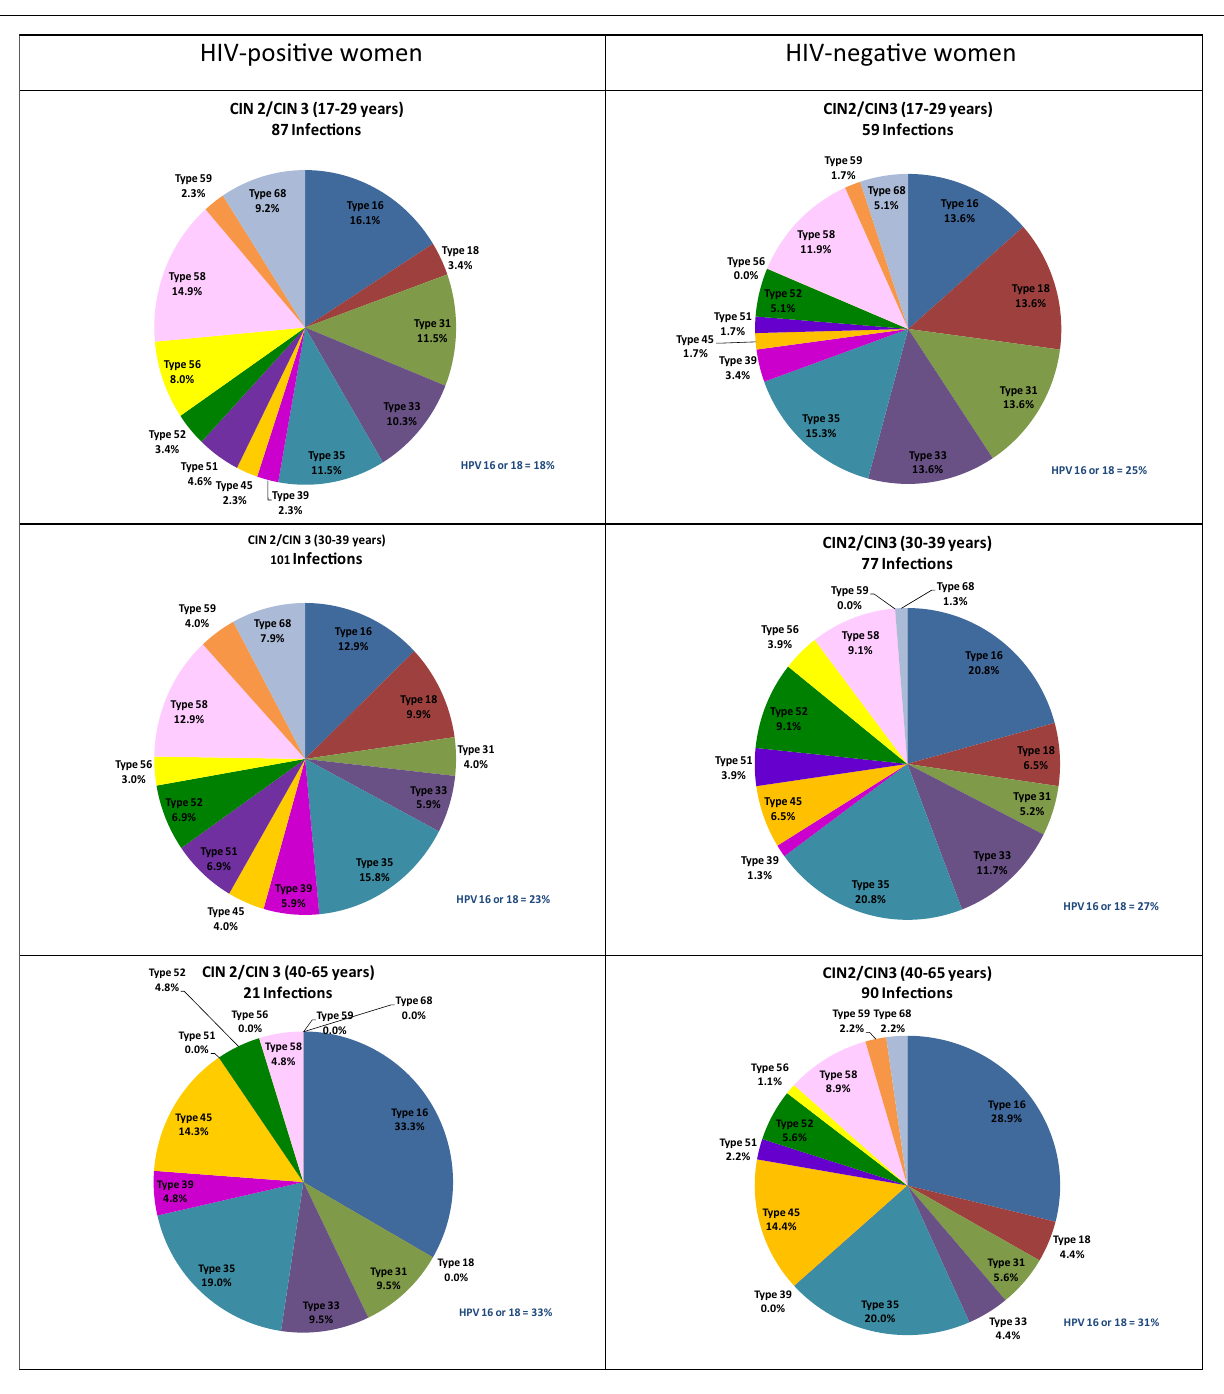
FIGURE 3 |Age-specific distribution of high-risk HPV genotypes of 209 infections among 117 HIV-positive women and 226 infections among 165 HIV-negative women with cervical intraepithelial neoplasia grade 2 or 3 . Note:WNL, within normal limits; CIN, cervical intraepithelial neoplasia; HR, high-risk; HPV, human papillomavirus. See Supplementary Material for